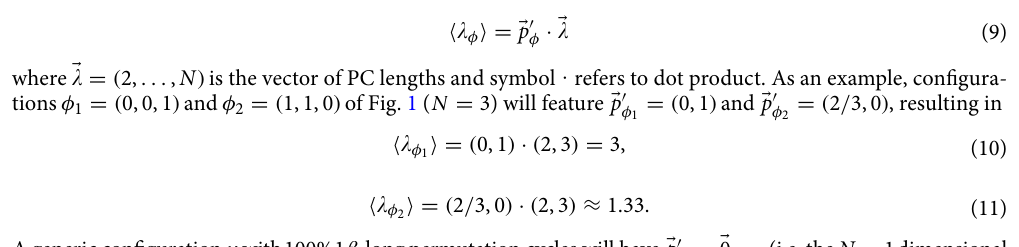
where � (cid:31) = ( 2, . . . , N ) is the vector of PC lengths and symbol · refers to dot product. As an example, configura-